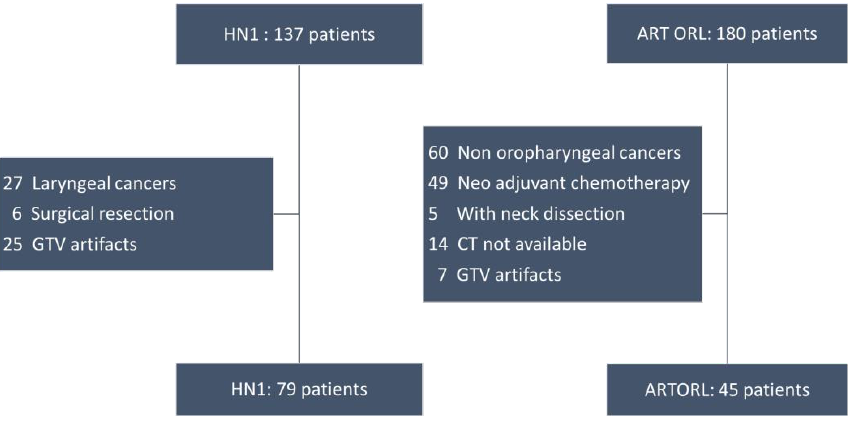
Figure 1. Flow charts of cohorts HN1 and ART ORL.